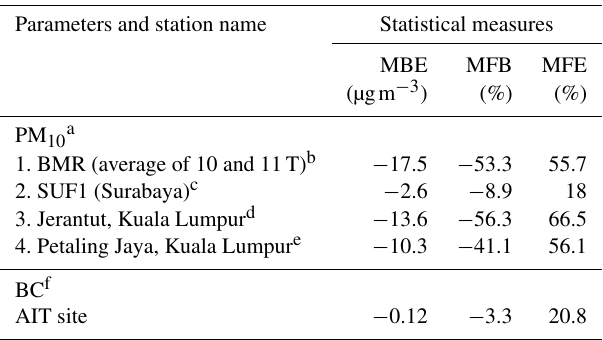
Table 4. Statistical parameters for CHIMERE model performance (PM 10 and BC)